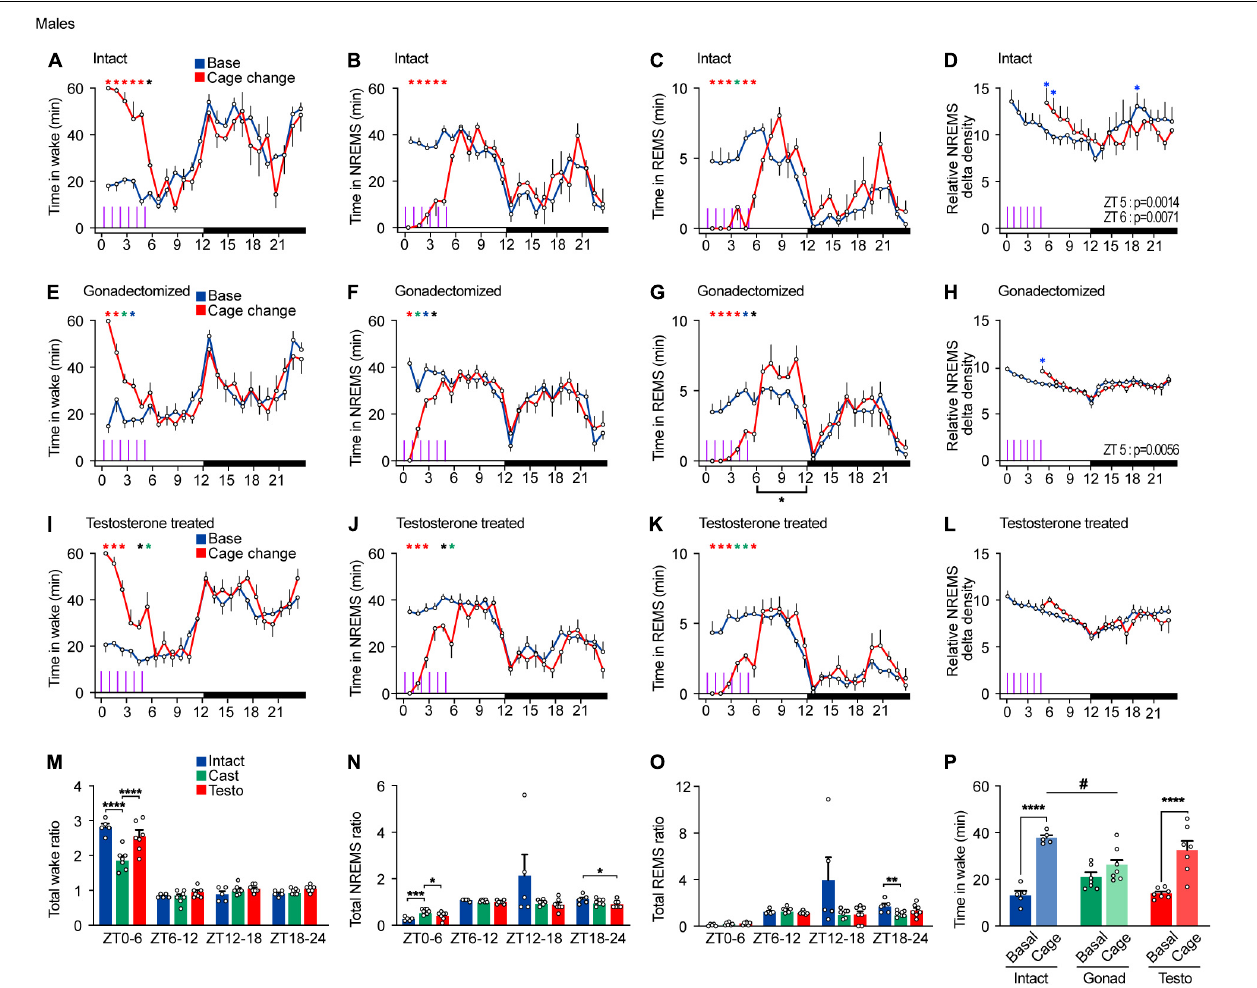
FIGURE 5 | Sleep/wake behavior of male mice in response to repeated cage changes. (A–D) Hourly wake time (A) , NREMS time (B) , REMS time (C) , and NREMS delta density (D) under the baseline condition and with six hourly cage changes from ZT0 in intact male mice; five mice. Two-way ANOVA followed by Sidak’s test. (E–H) Hourly wake time (E) , NREMS time (F) , REMS time (G) , and NREMS delta density (H) under the baseline condition and with six hourly cage changes from ZT0 in gonadectomized male mice; seven mice. Two-way ANOVA followed by Sidak’s test. (I–L) Hourly wake time (I) , NREMS time (J) , REMS time (K) , and NREMS delta density (L) under the baseline condition and with six hourly cage changes from ZT0 in testosterone-supplemented gonadectomized male mice; seven mice. Purple lines indicate cage changes. Two-way ANOVA followed by Sidak’s test. (M–O) Ratio of total awake time (N) , NREMS time (O) , and REMS time (P) to the baseline condition after repeated cage changes. Two-way ANOVA followed by Sidak’s test or Kruskal–Wallis test. (P) Wake time 2 h from ZT4 under baseline condition and with six hourly cage changes. One-way ANOVA followed by Sidak’s test and two-way ANOVA followed by Sidak’s test. * P < 0.05; ** P < 0.01; *** P < 0.001. # P < 0.05. * P < 0.05 (black); * P < 0.01 (blue); * P < 0.001 (green); * P < 0.0001